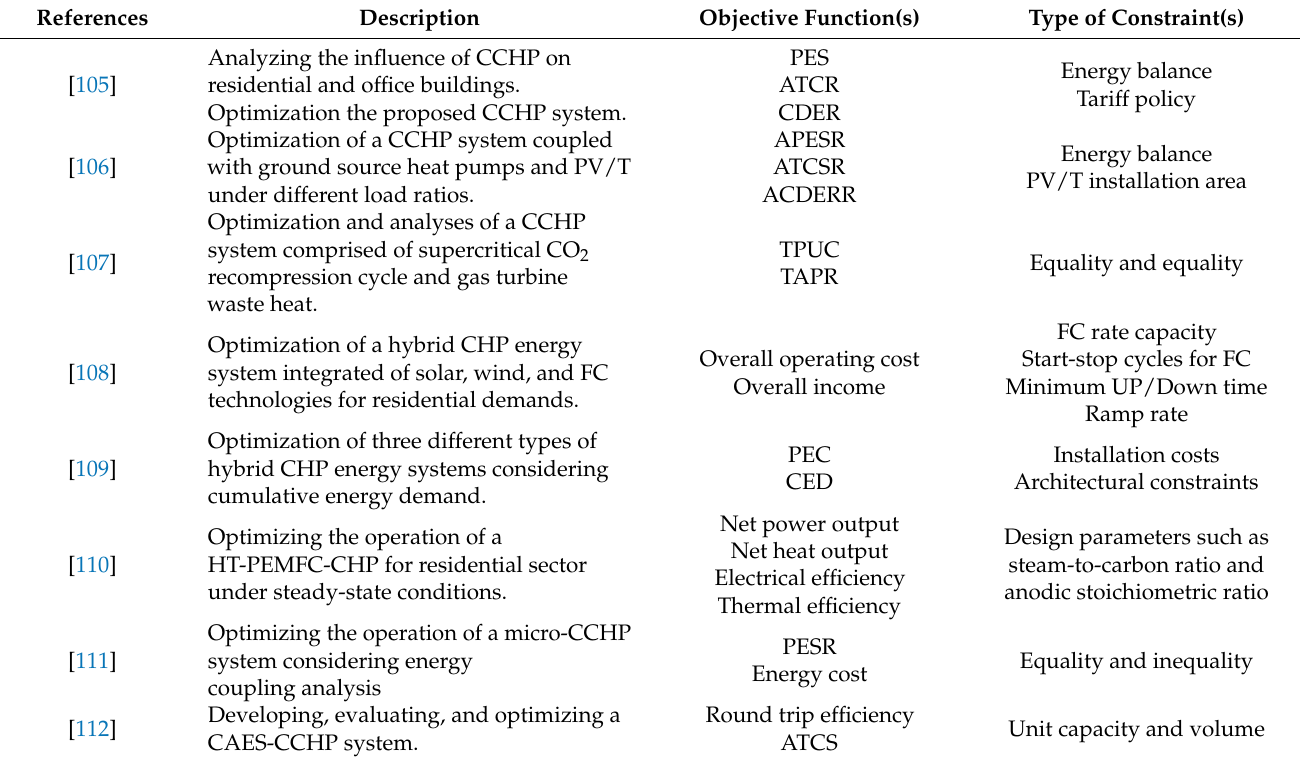
Table 1. Selected preliminary studies on energy system optimization using the GA